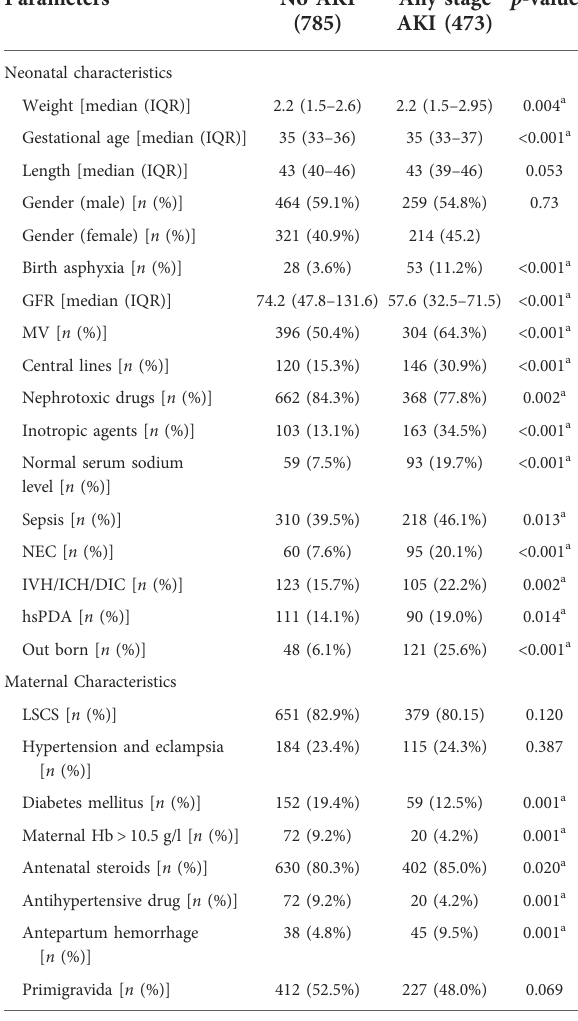
TABLE 1 Maternal and neonatal characteristics with and without